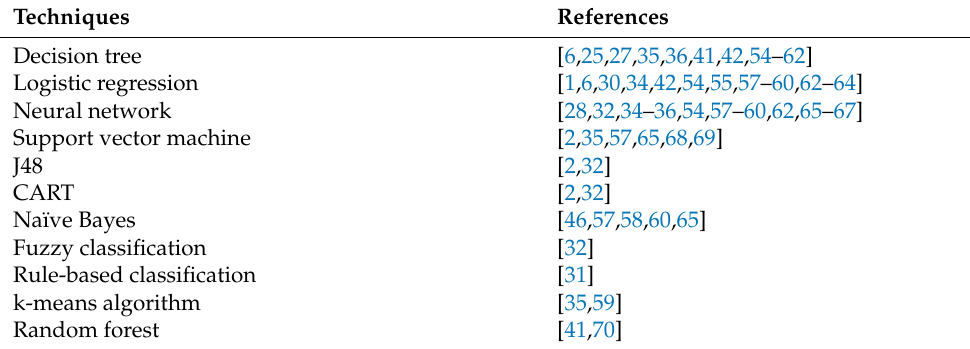
Table 3. Most Common Techniques Used for Customer Churn Prediction.